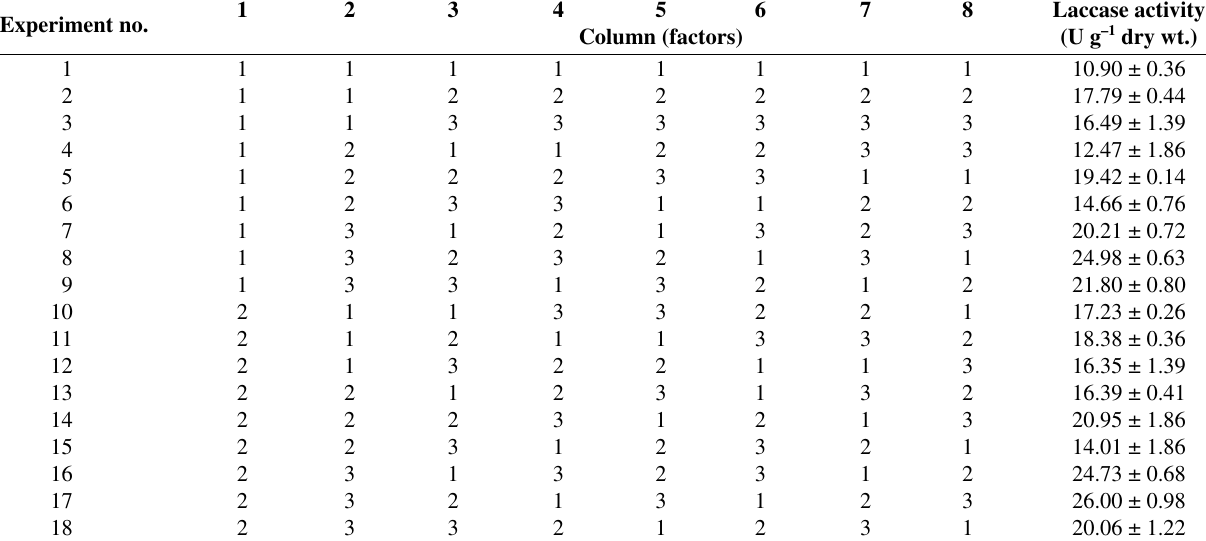
Table 2: Experimental design using Taguchi L18 orthogonal array Experiment no.